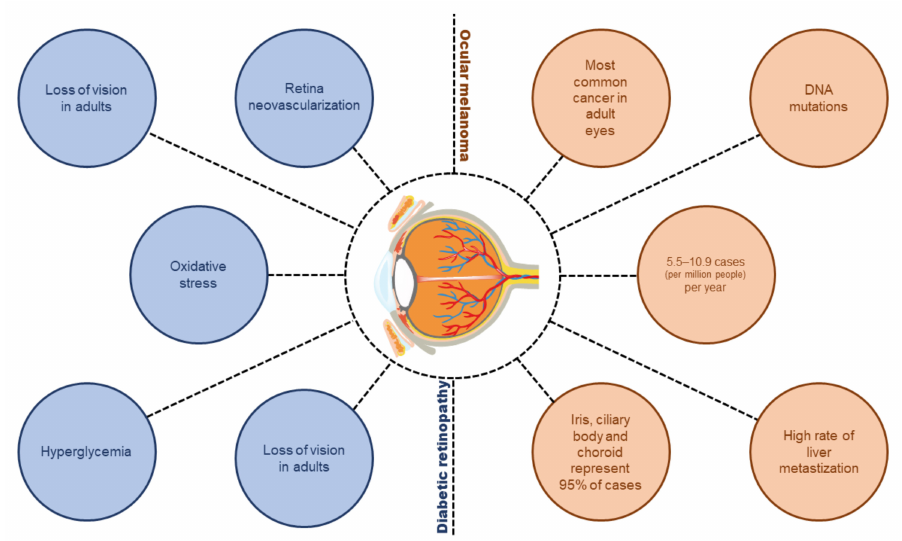
Figure 1. Main features of diabetic retinopathy ( left ) and ocular melanoma ( right